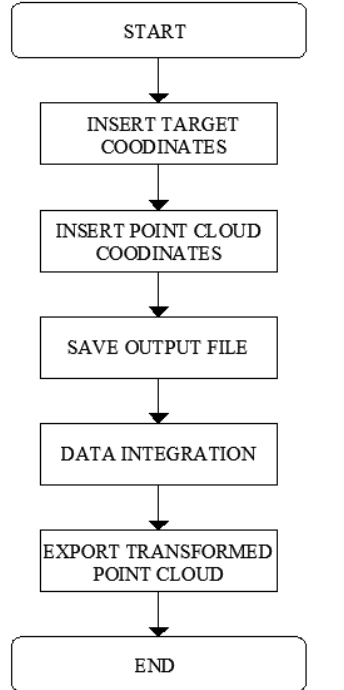
Figure 8: Flowchart of the Mirror transformation application